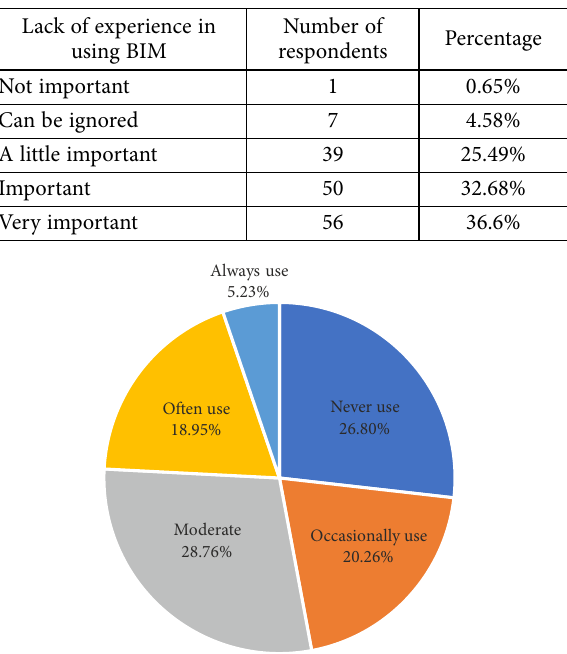
Table 6. Statistics table on the importance of the